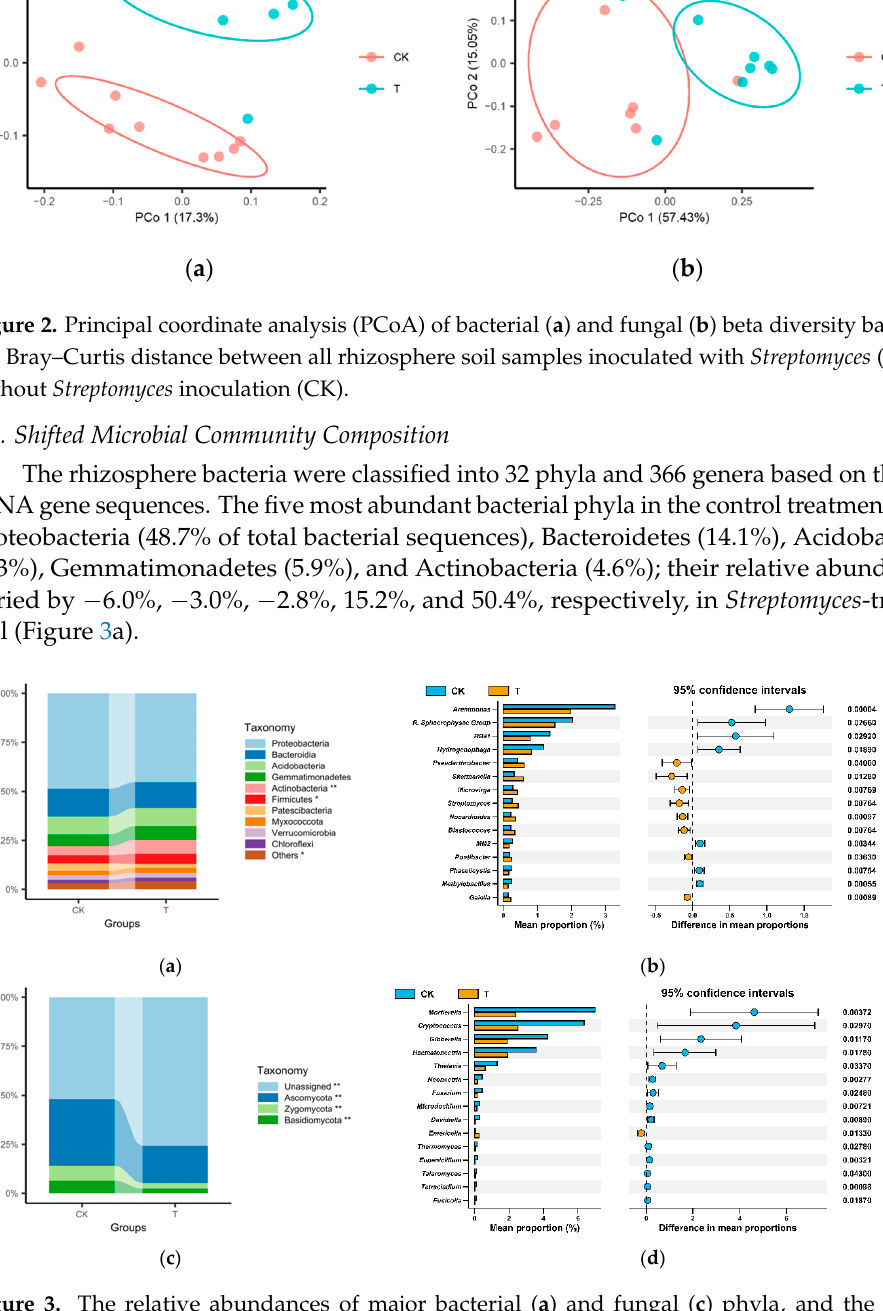
Figure 1. Alpha diversity of the rhizosphere microbiome associated with cucumber plants in Streptomyces -inoculated soil (T) and uninoculated control soil (CK). ( a ) Rarefaction curves of bacteria; ( b ) rarefaction curves of fungi; ( c ) richness index of bacteria; ( d ) richness index of fungi; ( e ) Shannon index of bacteria; ( f ) Shannon index of fungi. The horizontal bars within boxes represent the medians. The tops and bottoms of boxes represent the 75th and 25th percentiles, respectively. The upper and lower whiskers extend to data no more than 1.5× the interquartile range from the upper edge and lower edge of the box, respectively. Different letters above boxes indicate significant differences at p < 0.05.